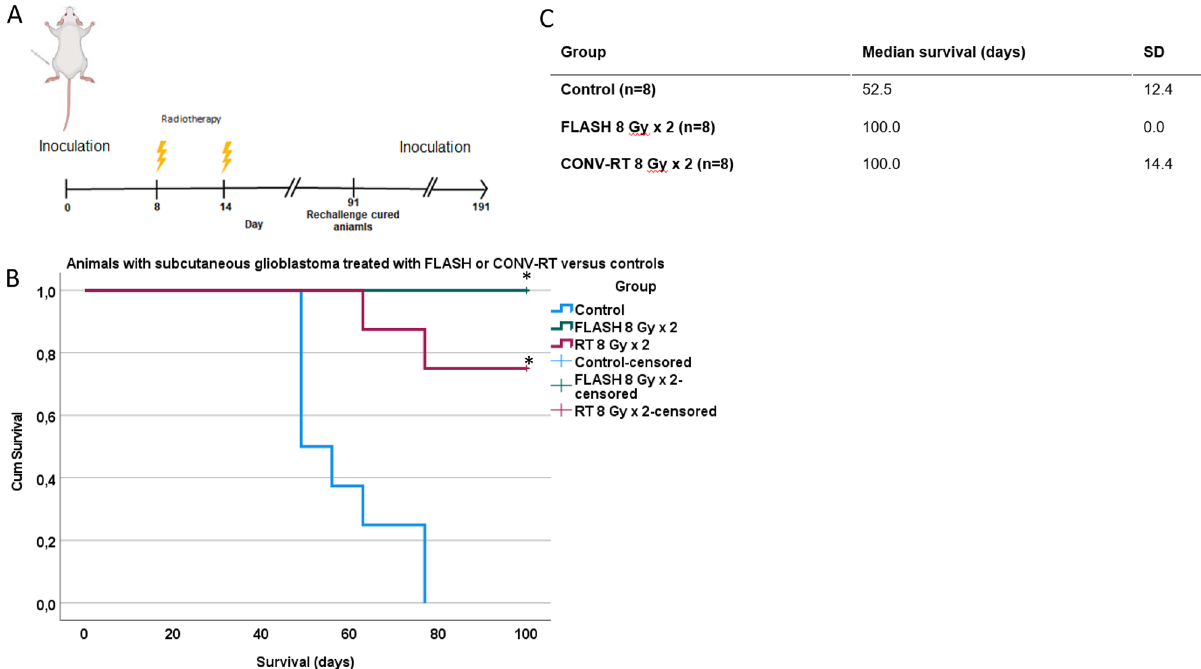
Figure 2. Survival in animals with subcutaneous tumors. ( A ) Experimental setup in animals with subcutaneous glioblastoma. Created with BioRender.com. ( B ) Survival (days) after first tumor cell inoculation. Survival differed significantly between the two irradiated groups compared to control animals. ( C ) Median survival in animals treated with CONV-RT 8 Gy × 2, FLASH 8 Gy × 2 or control